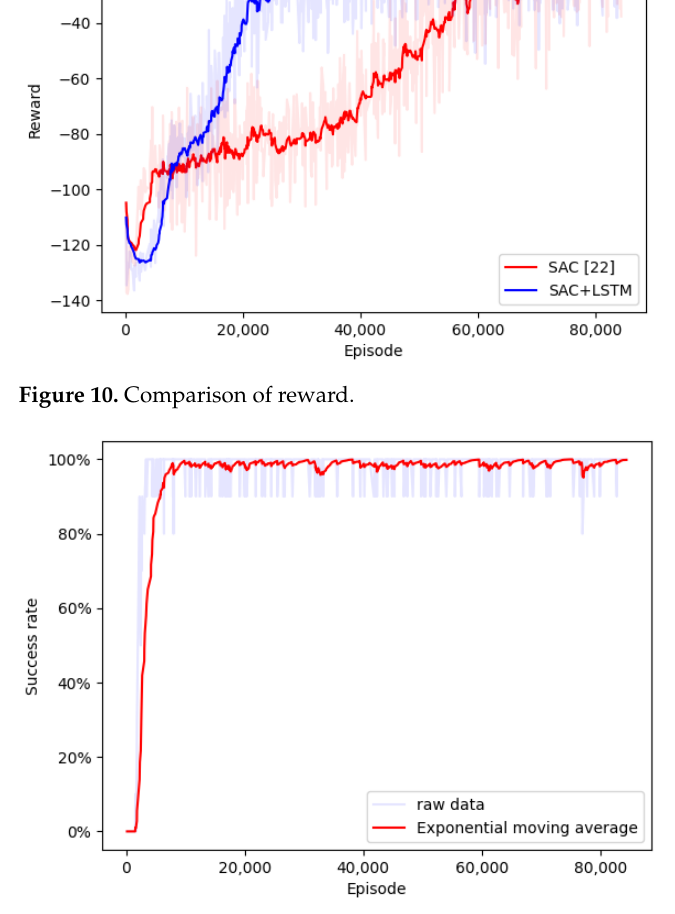
Figure 11. Experiment: success ratio of the proposed path planning in training.